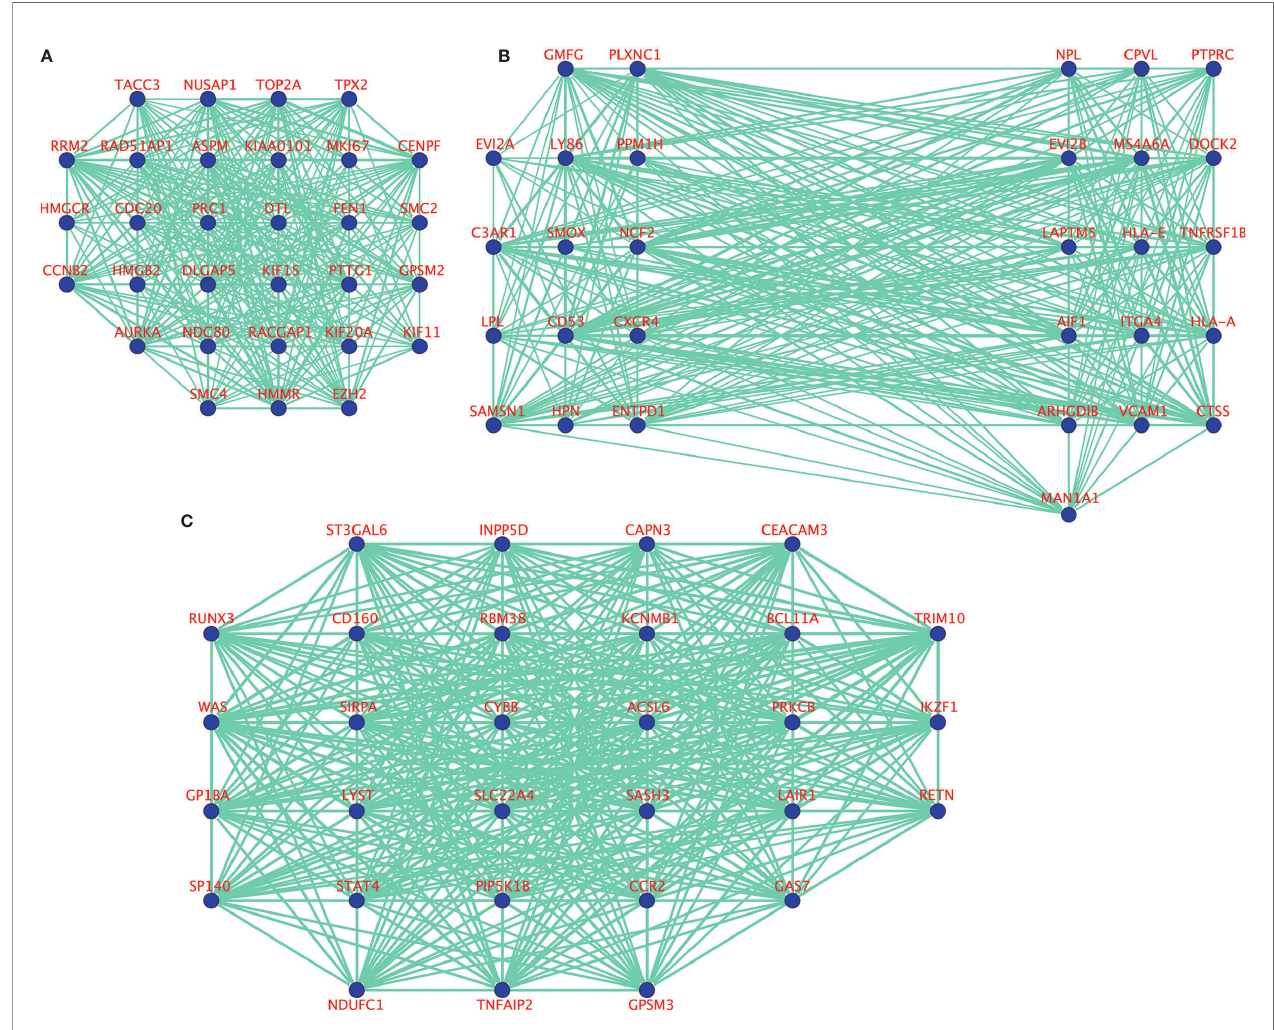
FIGURE 5 | The visualization of hub genes in green module (A) , yellow module (B) , and turquoise module (C)